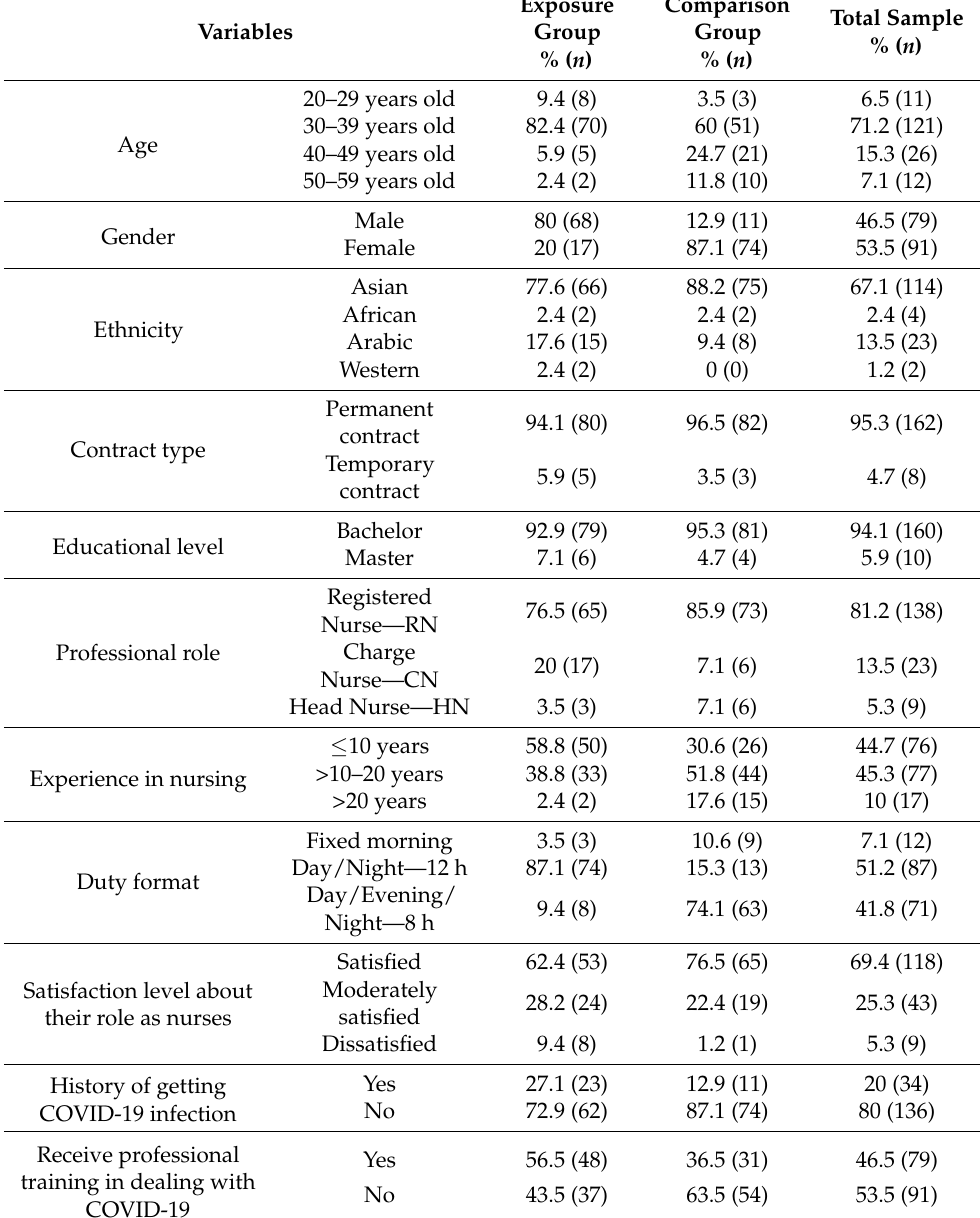
Table 1. Participants’ sociodemographic and work-related factors ( n =